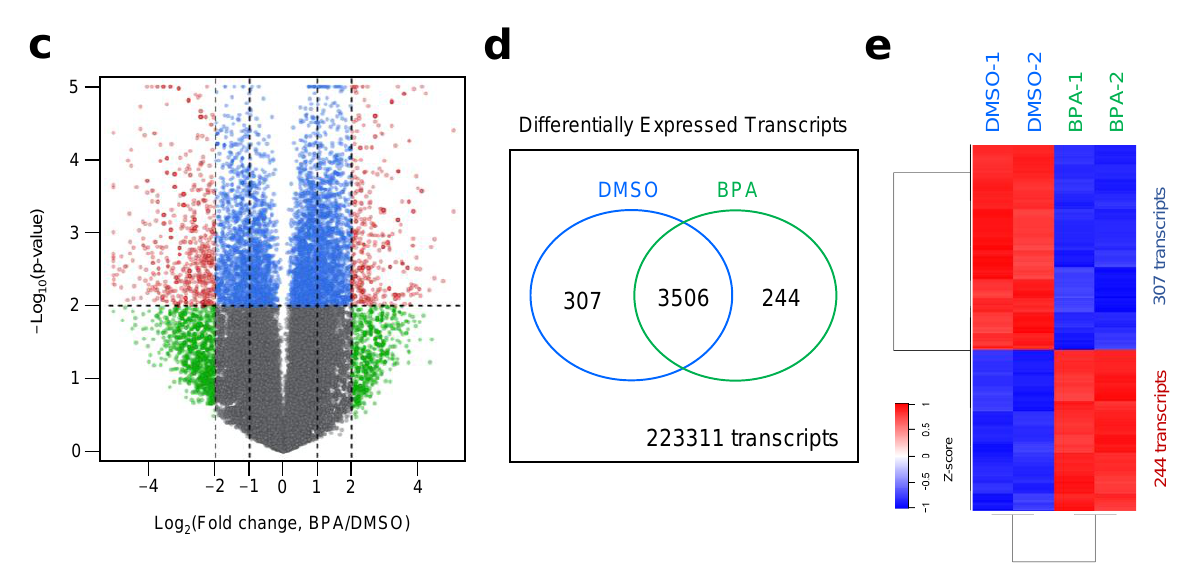
Figure 2 . Dynamic transcriptome profiles by the BPA treatment in Y79 retinoblastoma cells. Comparative analysis of transcriptome generated by directional RNA-seq from BPA treated Y79 cells. ( a ) Principal component analysis (PCA) of directional RNA-seq data. The values reveal the amount of variation attributed to each principal component. Small circles indicate individual samples, and larger ones show each group. ( b ) Transcriptional pattern analysis in control and BPA-exposed groups by employing heat map and hierarchical clustering. ( c ) Volcano plot shows differentially expressed transcripts in BPA treated group compared to the DMSO-treated group. Small red circled transcripts were verified as having the absolute value of log2 (fold changes) and −log10 ( p -value). ( d ) Differentially expressed transcripts were identified by the DEseq in BPA treated group from total annotated transcripts. ( e ) Heatmap depicting fold changes for all transcripts indicating statistically significant differences between the BPA-treated group and the control group.